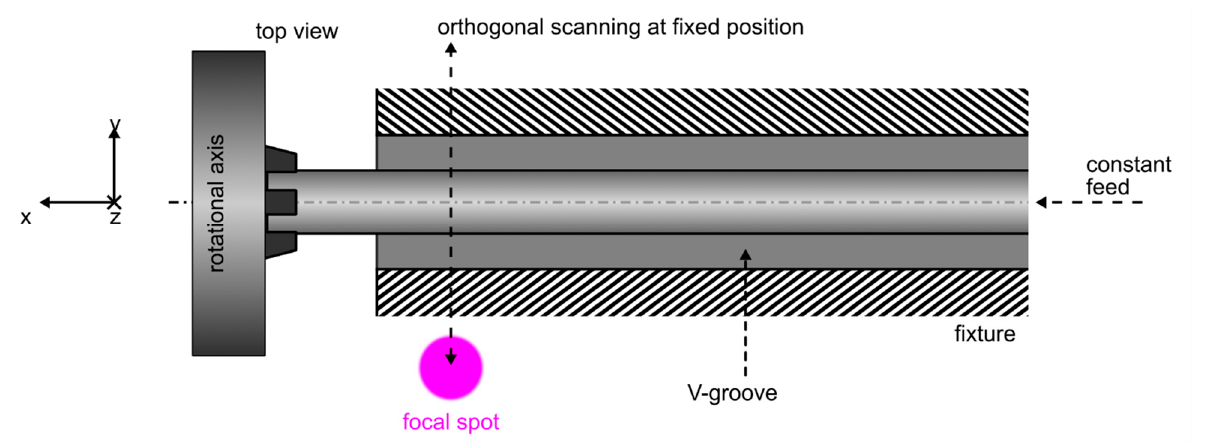
Figure 3. Femtosecond laser-based diameter reduction of sapphire rods over a length of 20 cm by means of an orthogonal scanning process.